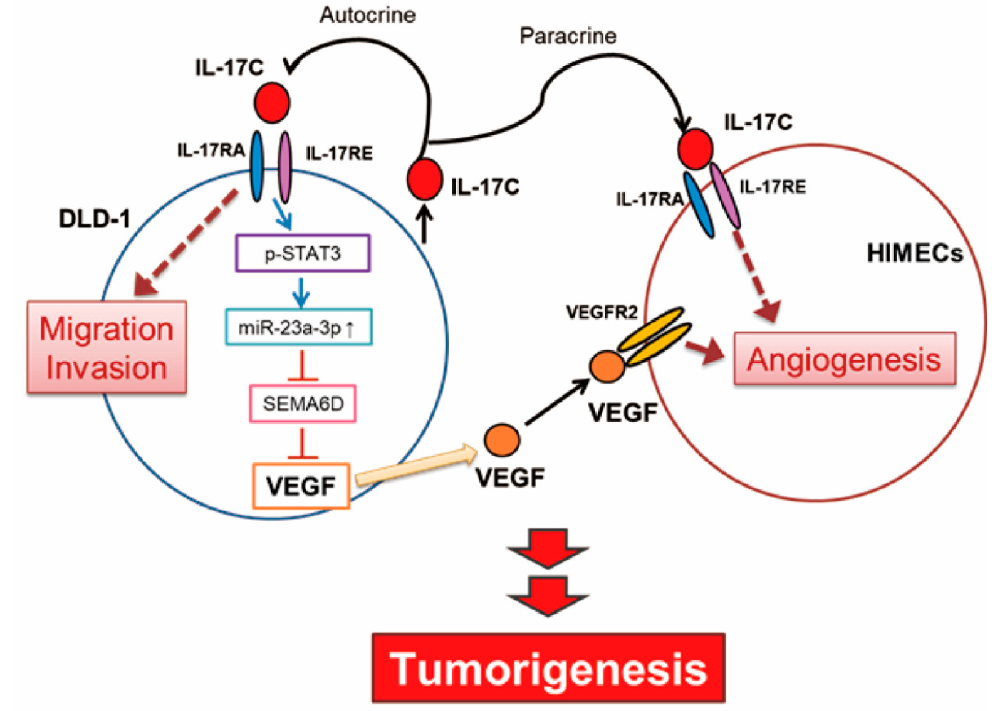
Figure 7. A schematic shows IL-17C-mediated molecular network and how miR-23a-3p regulates IL- 17C-induced tumor angiogenesis in colorectal cancer by promoting VEGF production. IL-17C-induced tumor angiogenesis in colorectal cancer by promoting VEGF